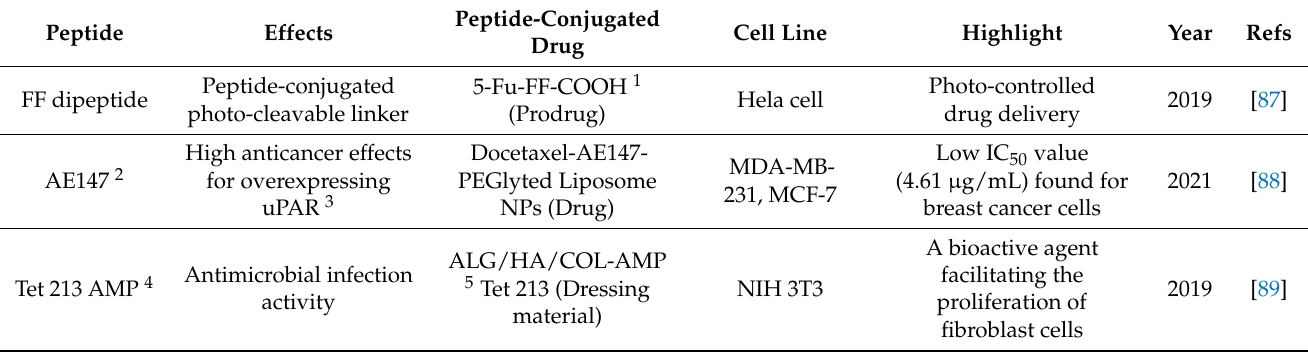
Figure 4. Several functional peptide-based drug carriers that have recently been actively studied. Table 1. Various peptide–drug conjugates for targeted anticancer